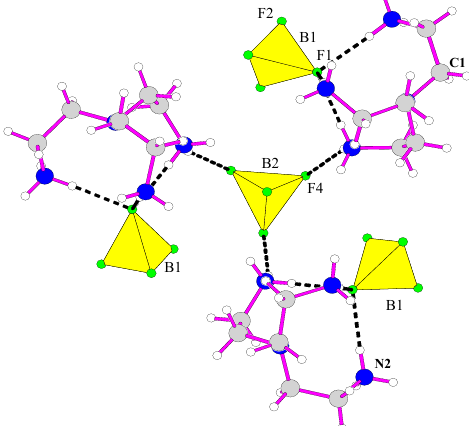
Figure 2. Environment of the BF 4 tetrahedron and [H 3 tren ] cation in the structure of [H 3 tren ](BF 4 ) 3.